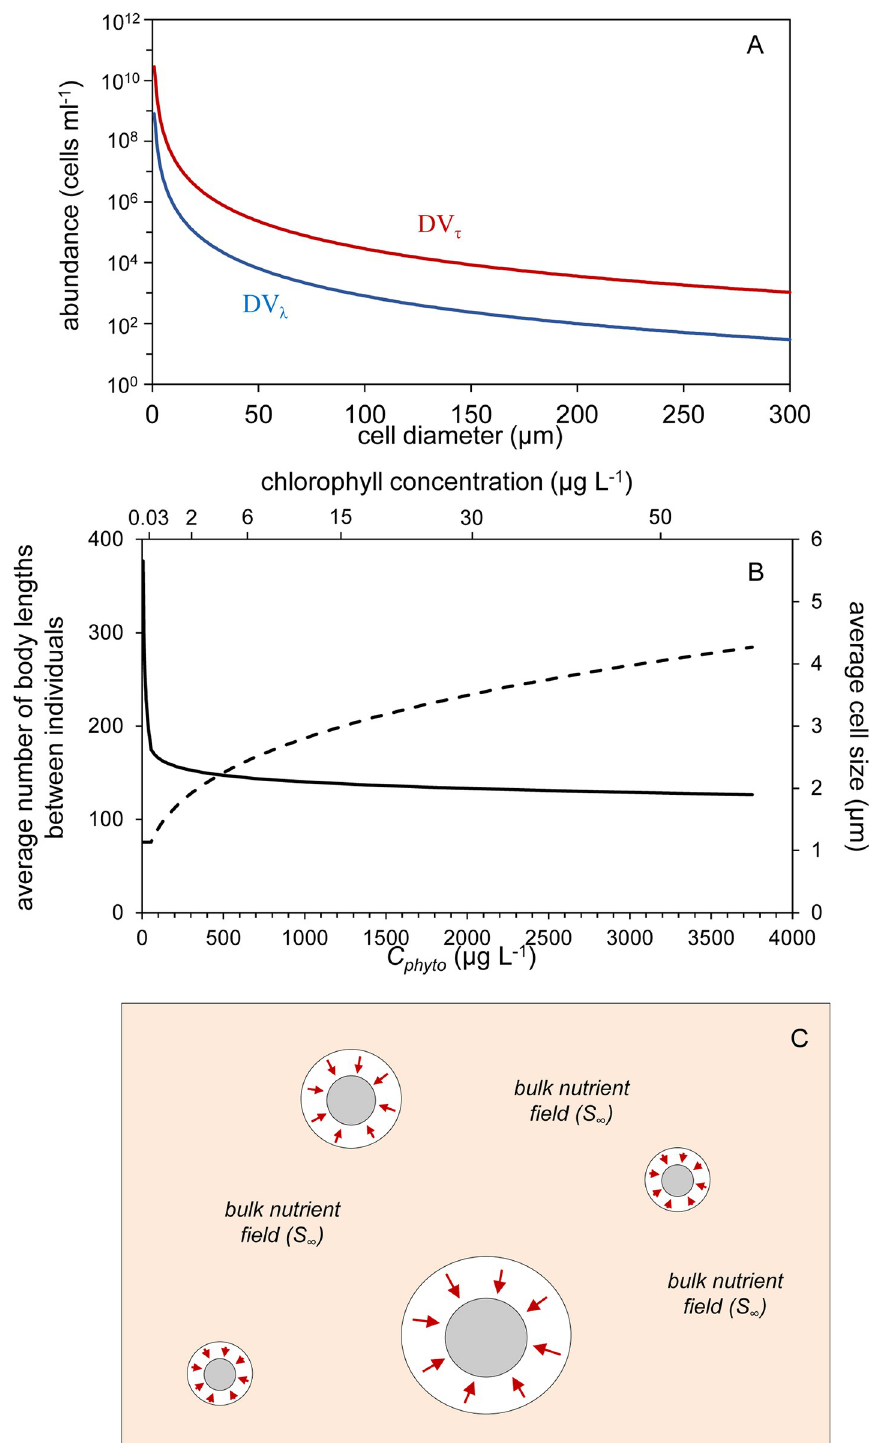
Fig 1. Conceiving the discreteness of phytoplankton communities. (A) Cell abundances for populations of a single cell size required for the spatial ( DV λ ) and temporal ( DV τ ) distribution variables defined by Siegel [12] to have a value of one, indicating direct competition for resources is prevalent. Note, these threshold values are notably larger than most natural population abundances. (B) Average number of body lengths between individual phytoplankton cells (left axis, solid line) and average population cell size (right axis, dashed line) for modeled phytoplankton communities